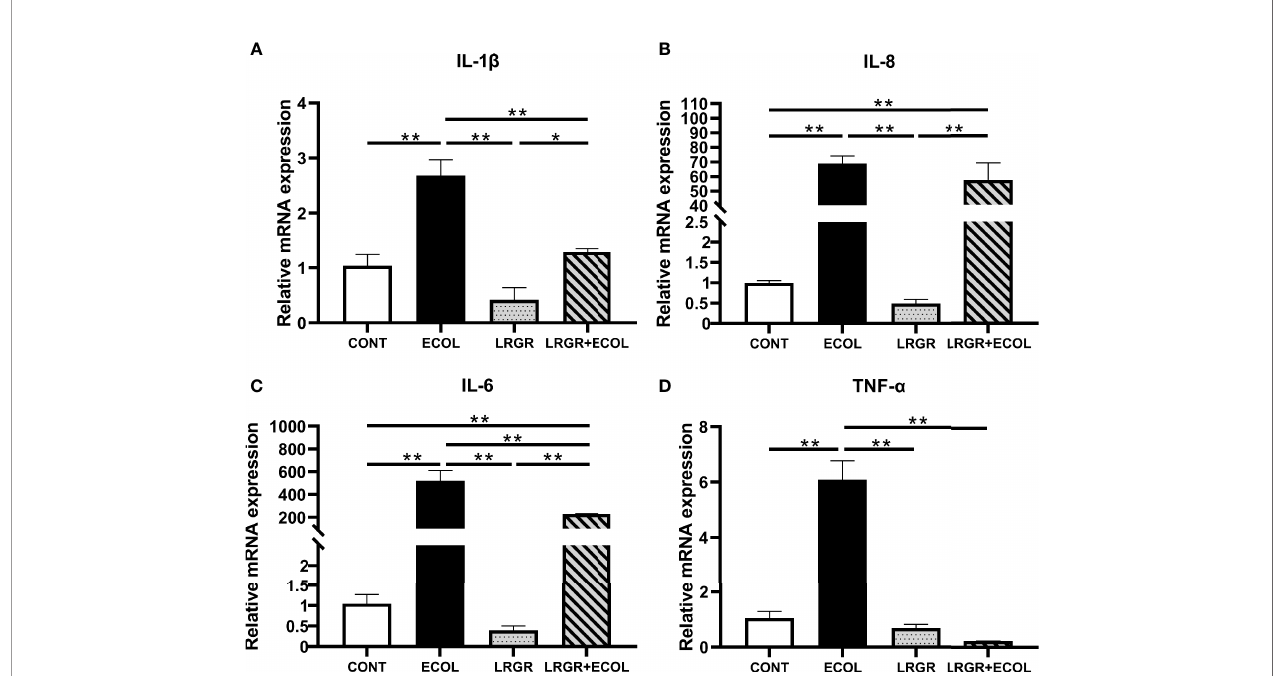
FIGURE 2 | Effect of L. rhamnosus GR-1 on the mRNA expression of in fl ammatory factors in BEECs induced by E . coli . IL-1 b , IL-8, IL-6, and TNF- a mRNA were quanti fi ed using the qPCR assay. (A) The expression of IL-1 b mRNA, (B) IL-8 mRNA, (C) IL-6 mRNA, and (D) TNF- a mRNA. Data represented are means ± SEMs from triplicate experiments. * P < 0.05, ** P < 0.01.